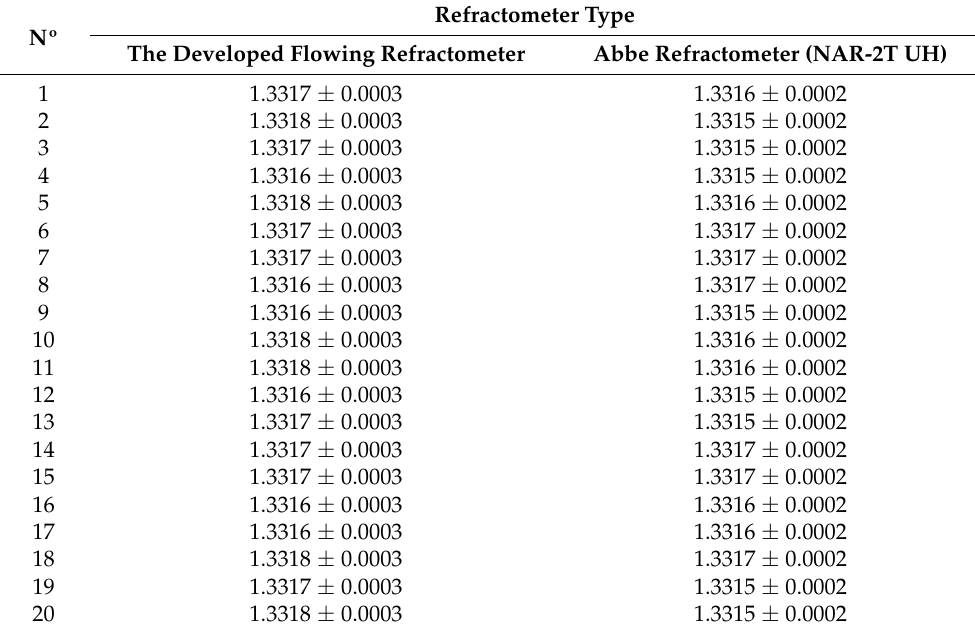
Table 1. Refractive indices n of feed water are measured by different types of refractometers.